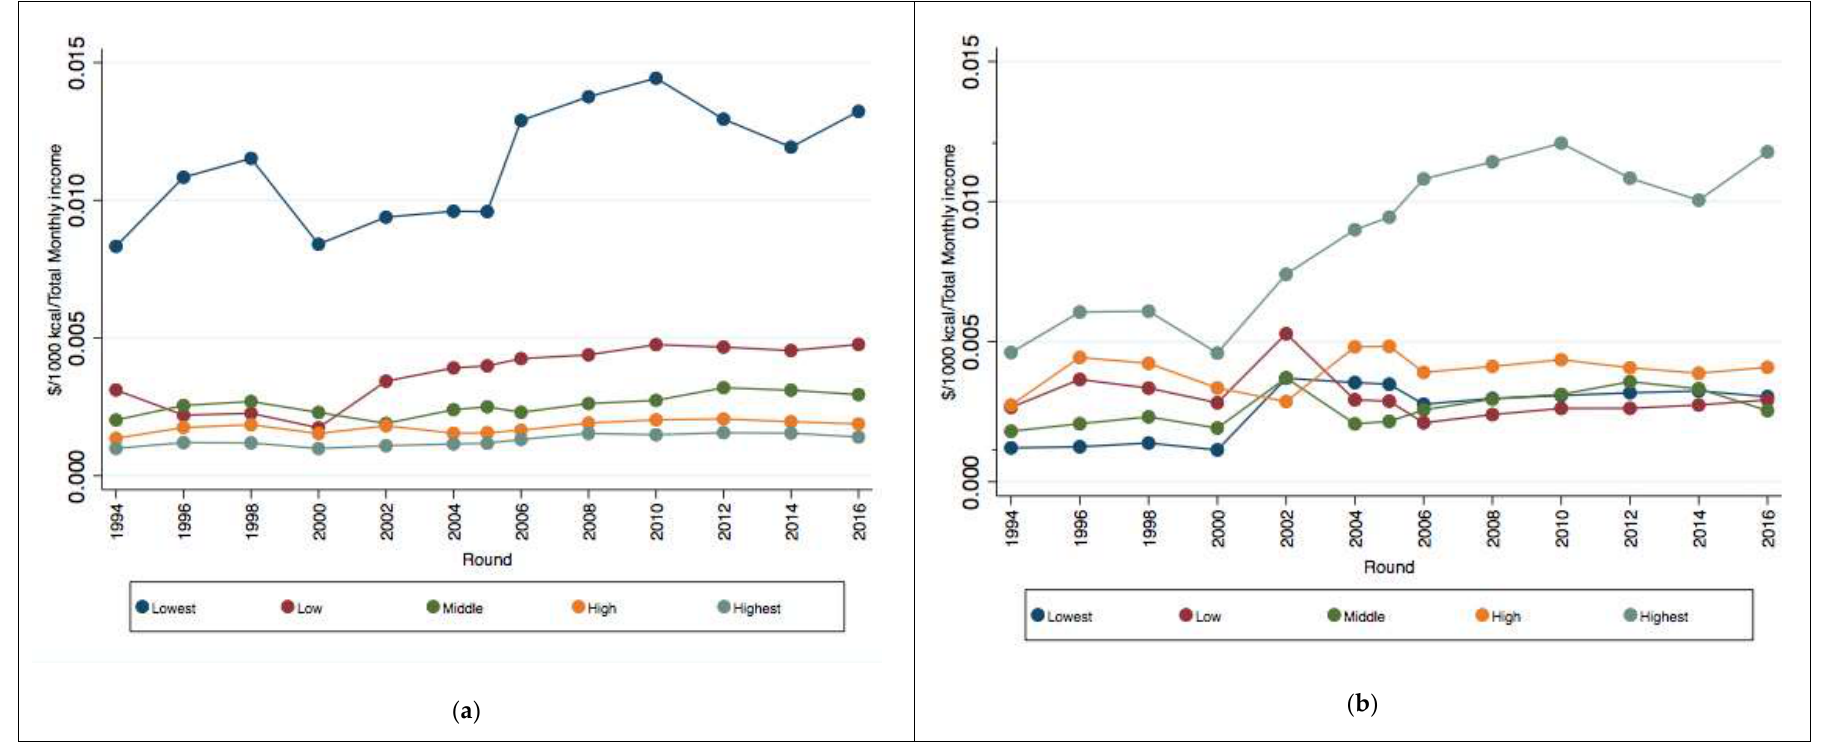
Figure 1. Affordability index ($/1000 kcal of food and beverages/household monthly income) of food and beverages, 1994–2016. Higher scores of the affordability index reflect lower affordability. ( a ) Affordability by quintile of energy density. ( b ) Affordability by quintile of the nutrient-rich food index. Authors’ estimations using the National Income and Expenditure Survey (1994–2016). Quintiles calculated on the 222 food categories.